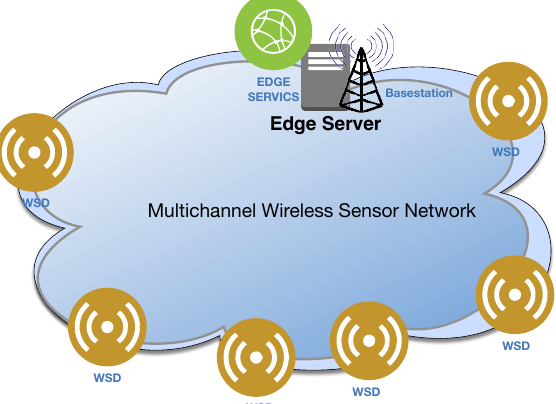
Figure 1. An Illustration of Computation Offloading for WSDs in a Multichannel Wireless Sensor